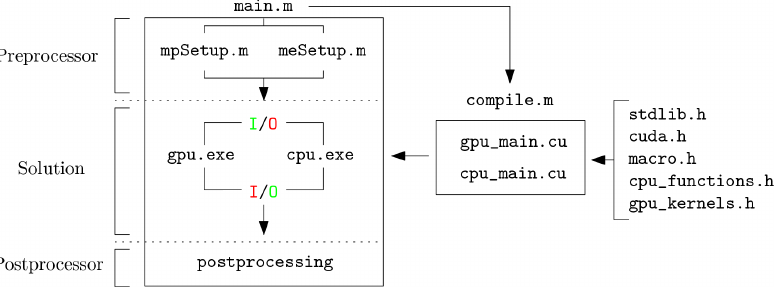
Figure 3. Multifunctional workflow: (1) usage of MATLAB for data initialization, compilation and postprocessing activities and (2) system calls to a performance compiled language such as C (CPU-based) and CUDA C (GPU-based) for heavy calculations. Here, I / O stands for input/output, and the colouring (red or green) specifies which one is active.